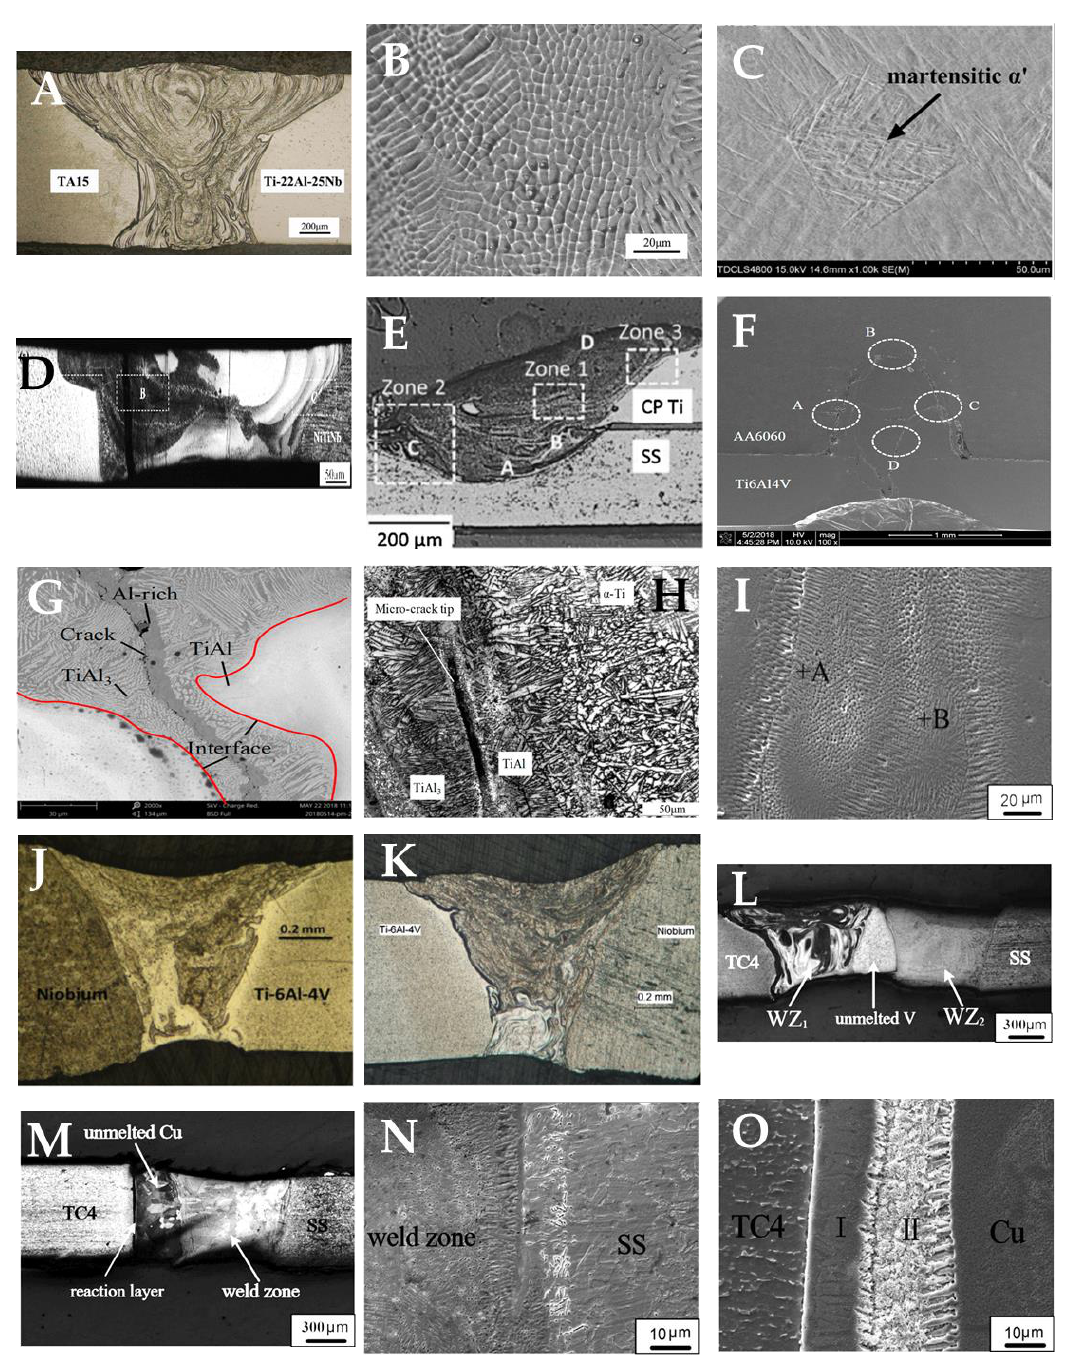
Figure 13. Pulsed laser weldments made of dissimilar titanium: Ti-22Al-25Nb and TA15 ( A ), its FZ ( B ) and HAZ ( C ) [79]; Ti6Al4V and NiTiNb ( D ) [80]; pure Ti and 304 stainless steel ( E ) [37]; Ti6Al4V and AA6060 lap joint ( F ), its interface ( G ) and crack ( H ) [81]; Ti6Al4V and pure Nb ( I ) [83]; Ti6Al4V and pure Nb ( J ) [82]; Ti6Al4V and 301L stainless with V interlayer ( K ) and its FZ ( L ) [84]; Ti6Al4V and 301L stainless steel with copper interlayer ( M ) and its weld interface ( N , O ) [85].